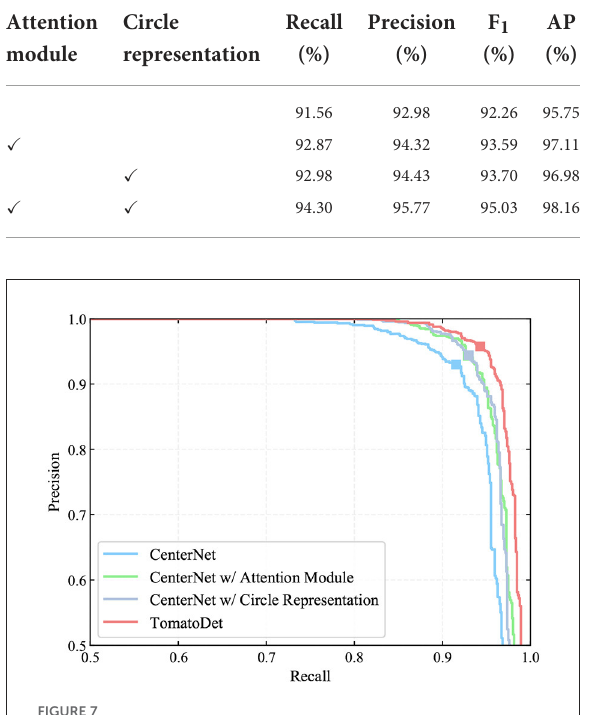
FIGURE7 PR curves of the major components of TomatoDet for ablation study. The markers indicate the points where recall and precision are obtained when the prediction confidence threshold equals 0.6.